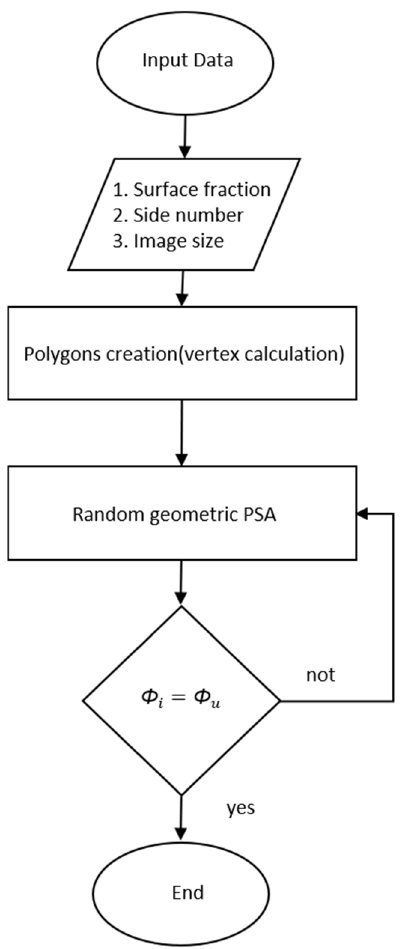
Figure 2. Flowchart for PSA generation.